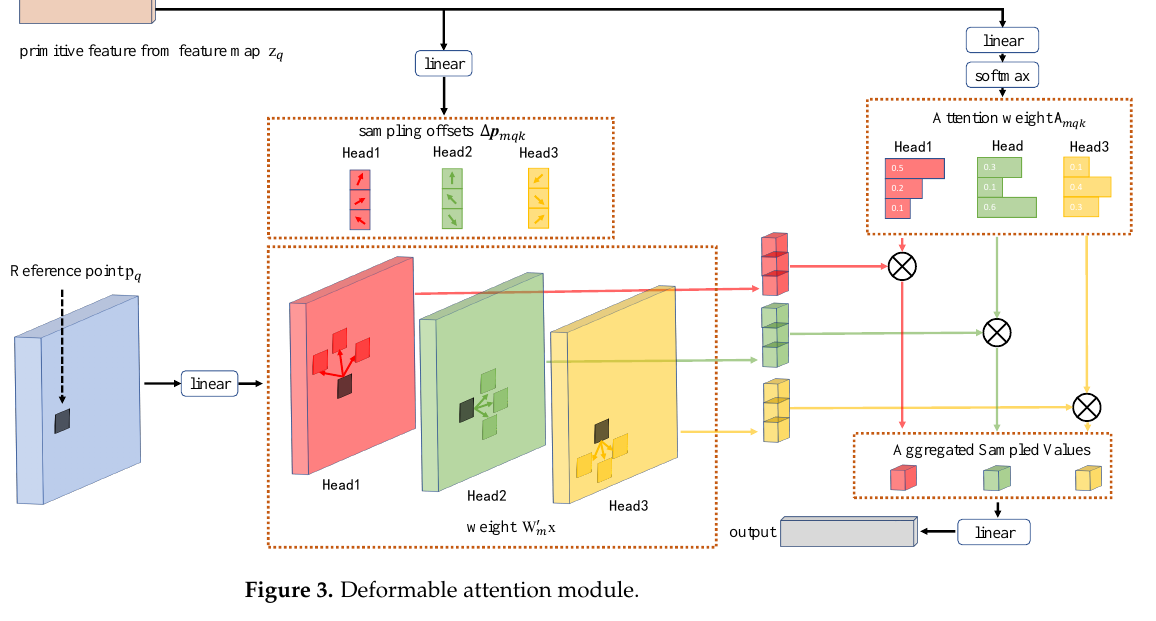
Figure 3. Deformable attention